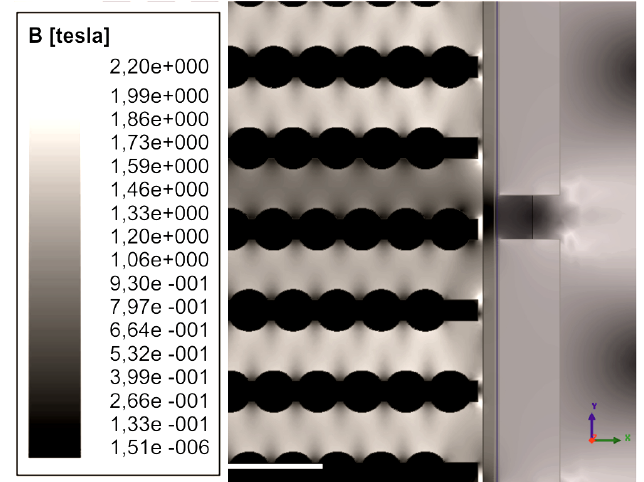
Figure 11. Induced magnetic flux density in stator, air-gap and back steel for 1 mm thickness of the closed slots.